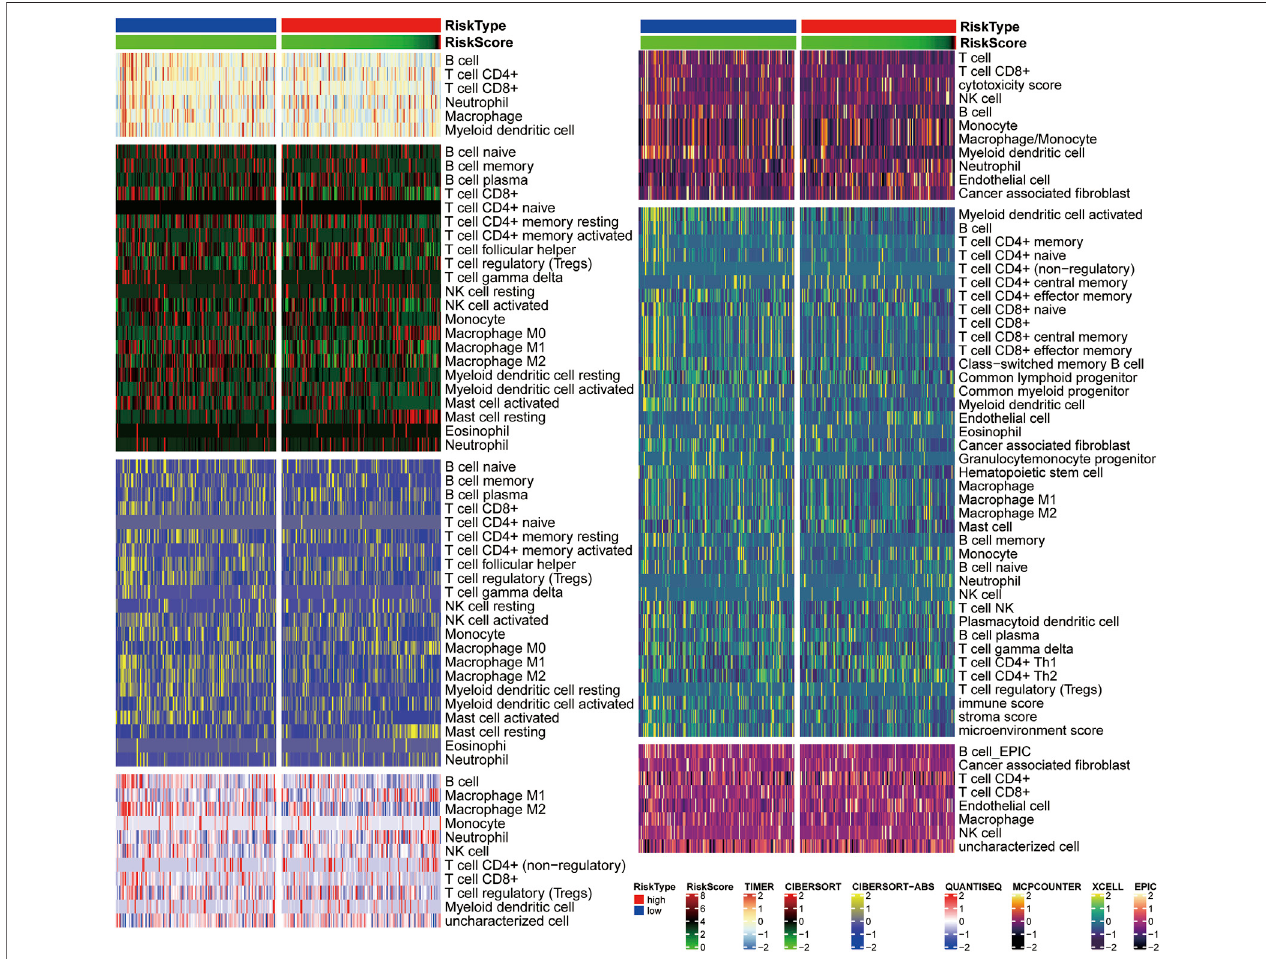
FIGURE 9 | Correlation analysis of immune cell in fi ltration and risk scores. A Heatmap of seven different methods shows relative in fi ltration levels in high- and low- risk groups.